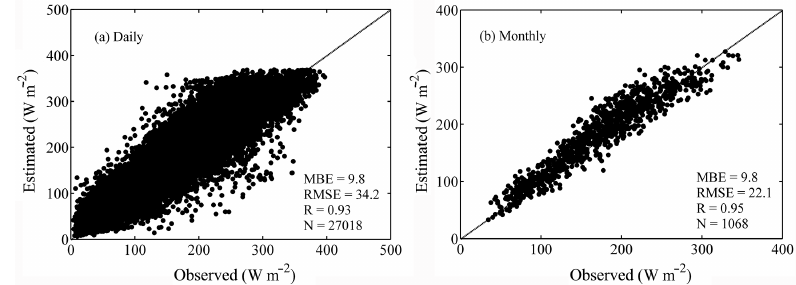
Figure 8. (a) Comparison between the observed and the estimated daily SSR at all CMA radiation stations in 2009. (b) Similar to panel (a) , but for monthly SSR. Units of MBE and RMSE are Wm − 2